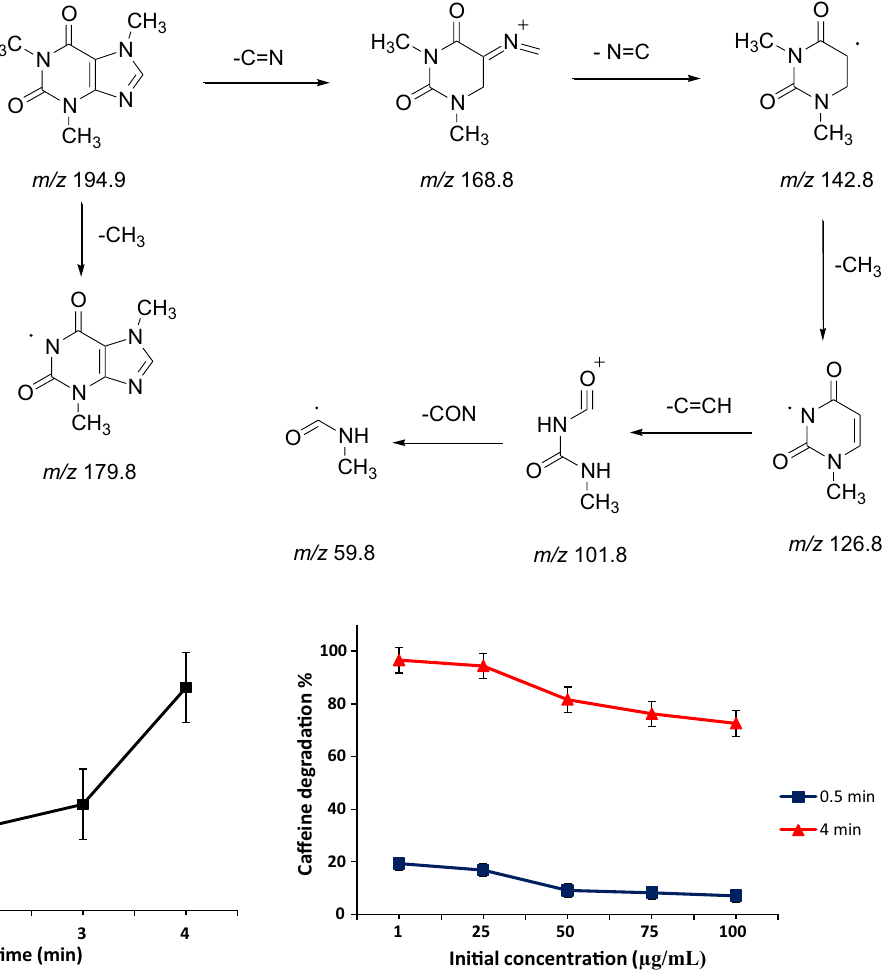
Fig. 5 Removal efficiency of caffeine from water with initial concen- trations of 1, 25, 50, 50, 75 and 100 µg/mL at 0.5 and 4 min DBD plasma treatment. Initial pH: 7 and input plasma power: 60